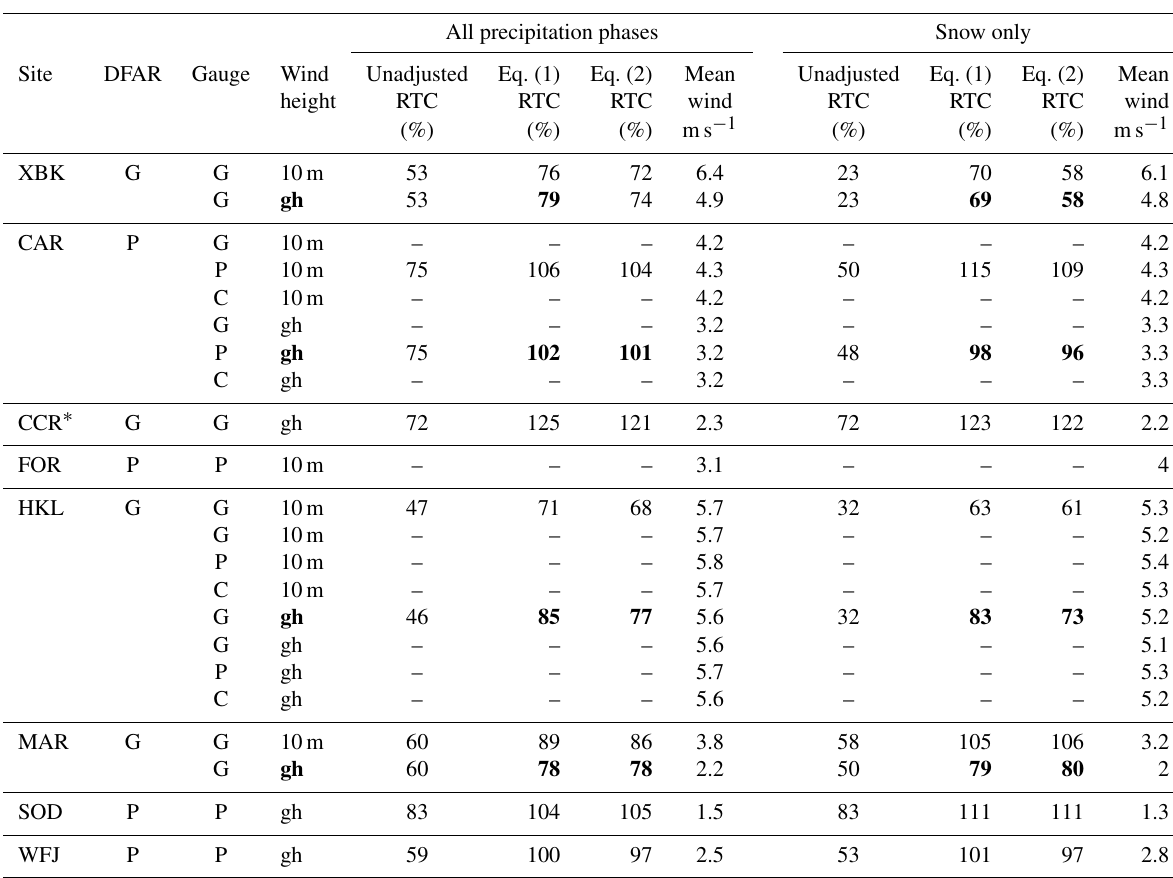
Table 3. Relative total catch (RTC) for the unshielded gauges (G – Geonor; P – Pluvio 2 ) as compared to the DFAR reference at each site for the combined winters of 2015/2016 and 2016/2017. Results are provided for available wind speed measurement heights (10m; gh – gauge height) and for Eqs. (1) and (2). Metrics are separated by precipitation phase (all and snow only). Where both wind speed heights are available, the gauge height data are shown in